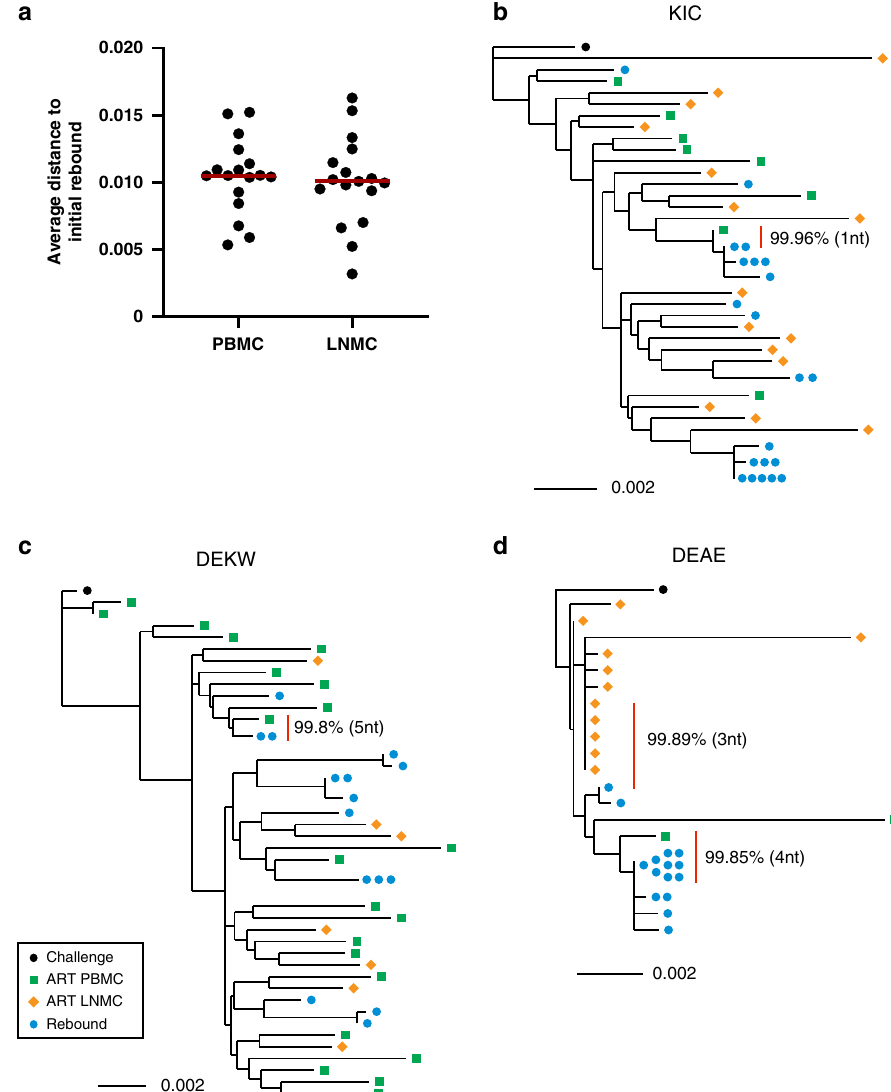
Fig. 5 Initial rebound viral RNA sequences compared with rcNFL viral DNA sequences from PBMC and LNMC. a Average distance of env sequences from the initial rebound virus to rcNFL viral DNA in PBMC and LNMC in each animal ( n = 16). b to d Phylogenetic trees of initial plasma rebound viral RNA sequences following ART discontinuation and rcNFL viral DNA sequences from PBMC and LNMC from three animals (KIC, DEKW, DEAE). The closest matches are indicated with a vertical red line with the sequence identity